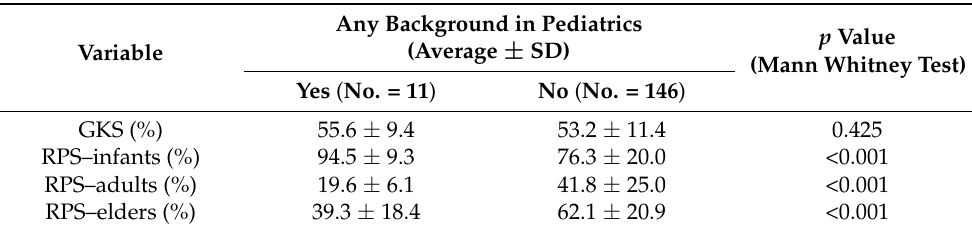
Table A4. Comparison of cumulative scores by having or not any background in pediatrics (Note: SD = Standard Deviation).